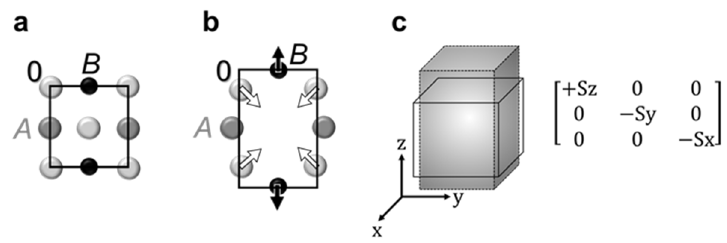
Figure 2. Oxygen vacancy. Schematics of ( a ) regular correct oxygen stoichiometry ( AB O 3 ) perovskite cell, ( b ) distortions around oxygen vacancy, and ( c ) oxygen-vacancy elastic dipole.